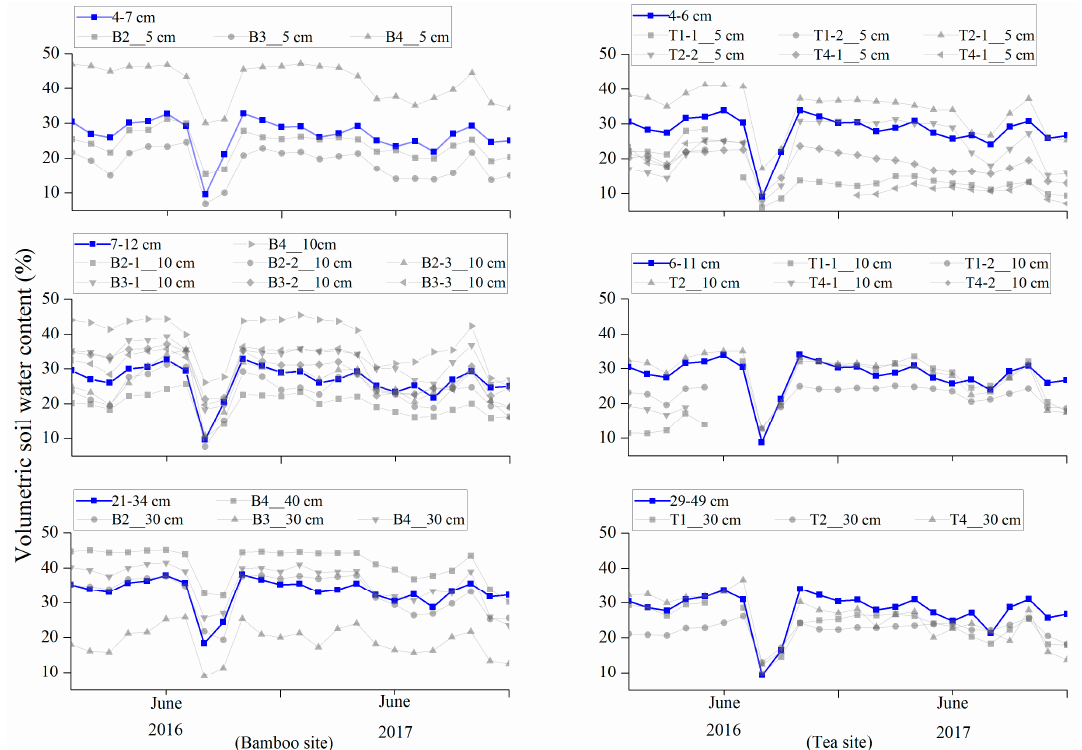
Figure 5. Observed and modeled soil water content by soil depth at the two study plots.